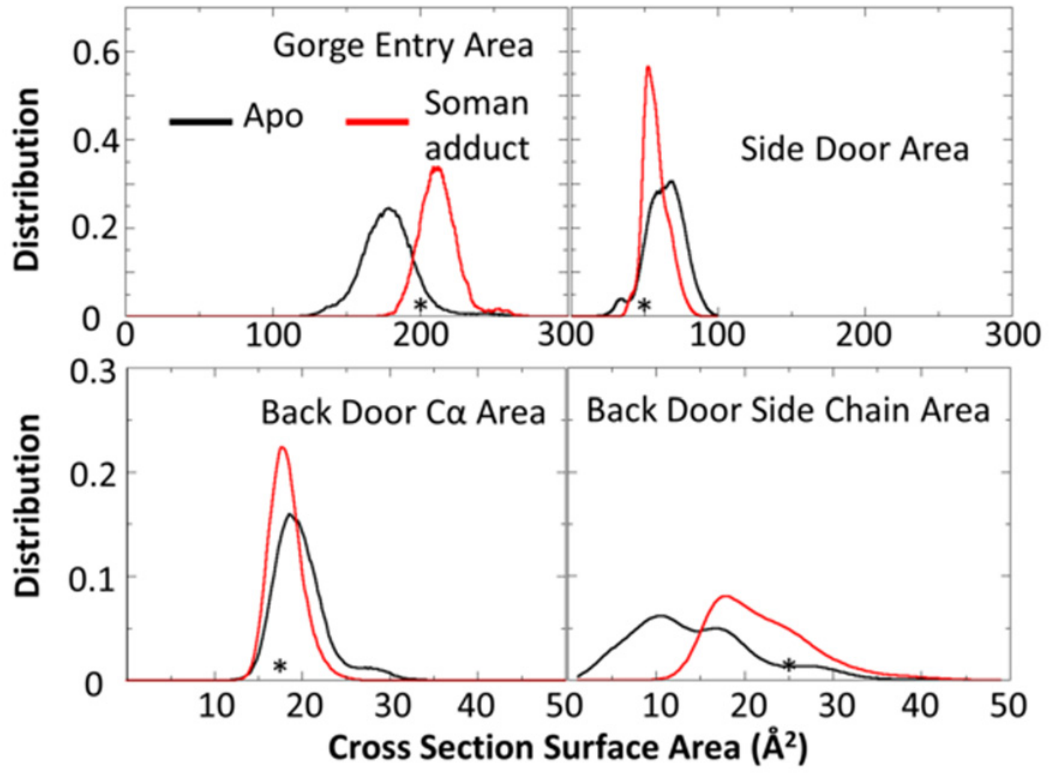
Fig 8. Cross-sectional area distributions for three protein regions are shown for the apo (black) and soman-adducted (red) MD structures. Only the gorge entry and back door sidechain regions of the soman-adducted hAChE protein experience a shift to larger cross-sectional area values relative to the apo trajectories while the other areas are similar or diminished in area. These data suggest the soman adduct is shifting the protein into a more restrained set of conformations. The asterisk denotes the cross-sectional area of comparable atoms in the TcAChE apo and soman adducted